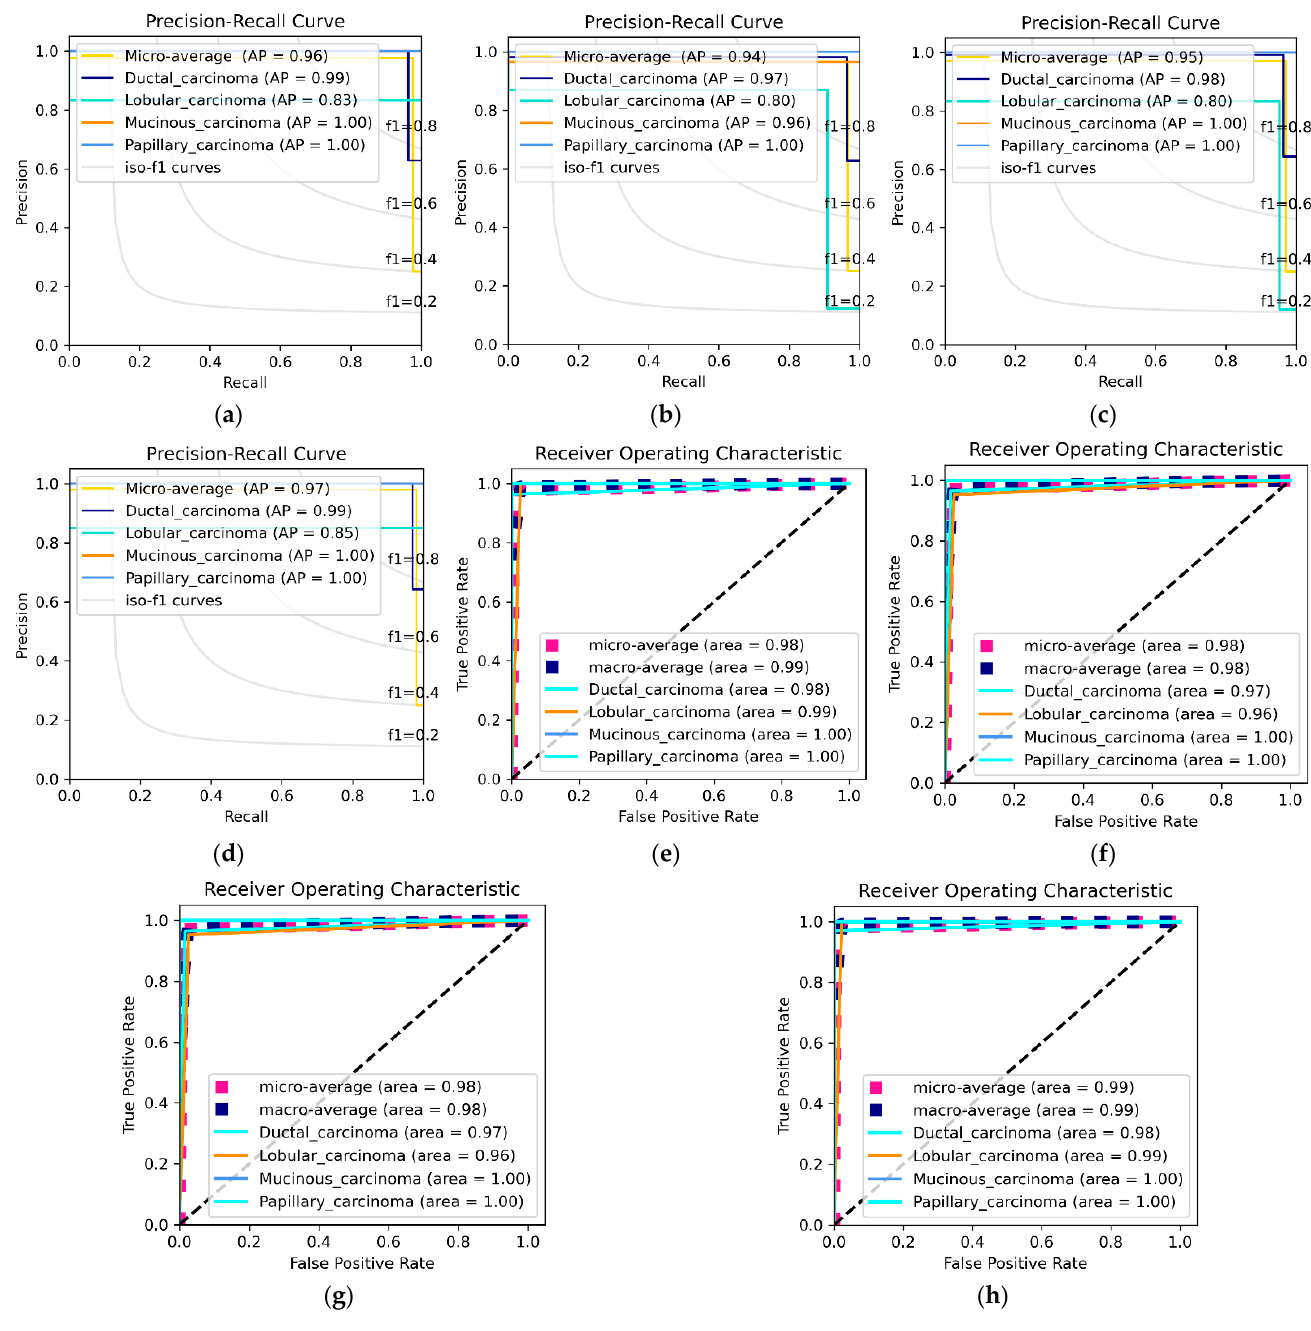
Figure 8. Malignant Multiclass Classification. ( a ) depicts the PR Curve @40 × , ( b ) depicts PR Curve @100 × , ( c ) depicts PR Curve @ 200 × , ( d ) depicts PR Curve @ 400 × , ( e ) depicts ROC curve @ 40 × , ( f ) depicts ROC curve @ 100 × , ( g ) depicts ROC curve @ 200 × , and ( h ) depicts ROC curve @ 400 ×